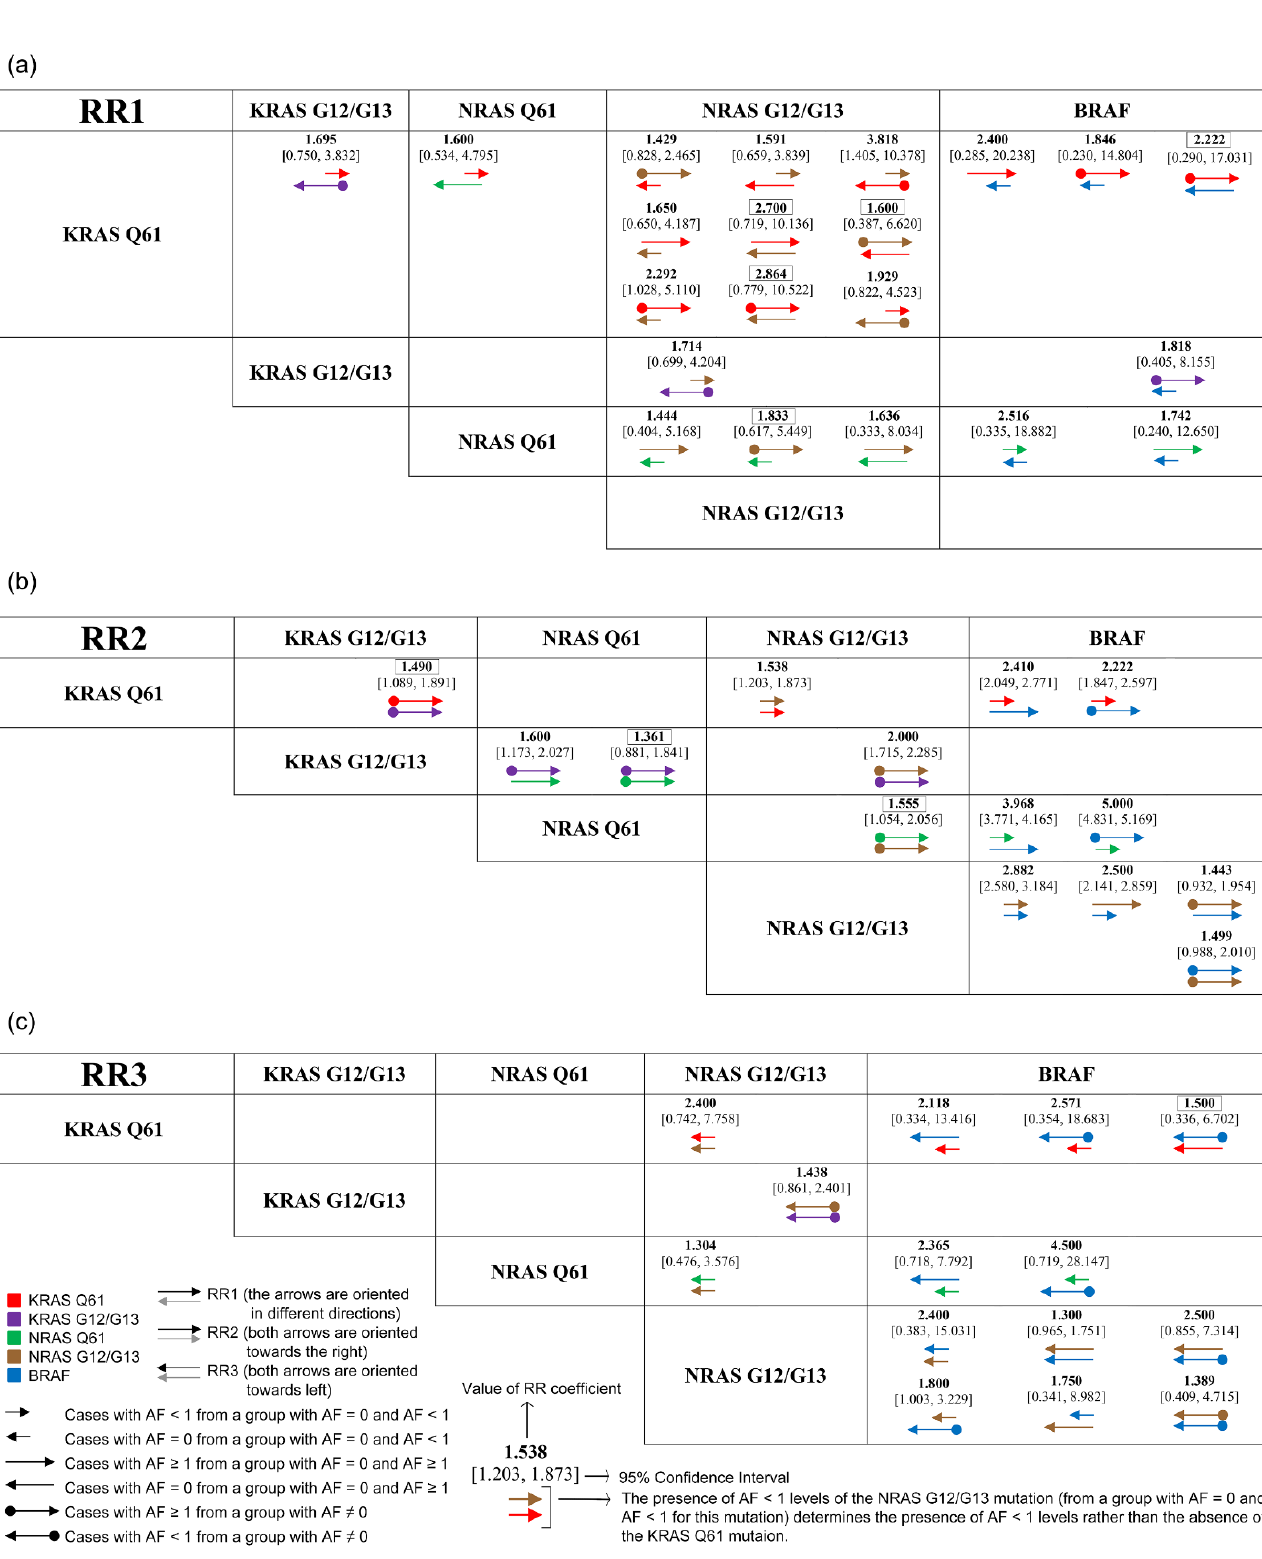
Figure 1. Risk analysis via RR1 ( a ), RR2 ( b ), and RR3 ( c ) of all possible two-by-two associations between the studied mutations. The section “coexistence of mutations and their associations with clinical data” in the Supplementary Materials file contains the equations defining RR1, RR2, and RR3. Table S3 contains the interpretation of these risk estimators. We selected the statistically significant values from the data presented in Supplementary Materials Figure